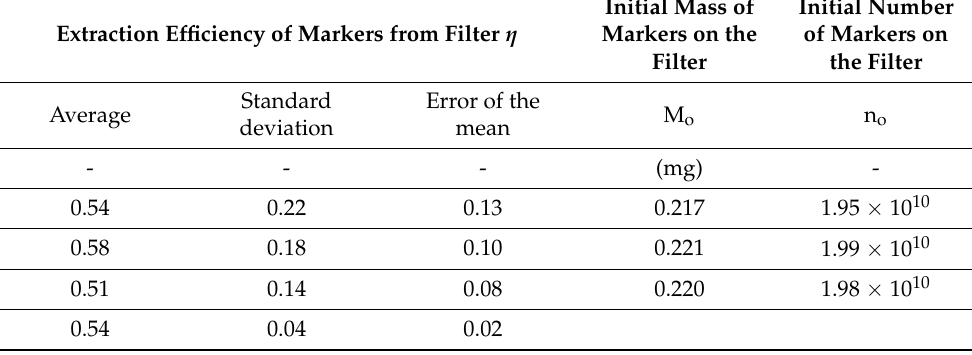
Table 8. Extraction efficiency of 200 nm markers taking into account the results of only the first and fourth extraction steps.